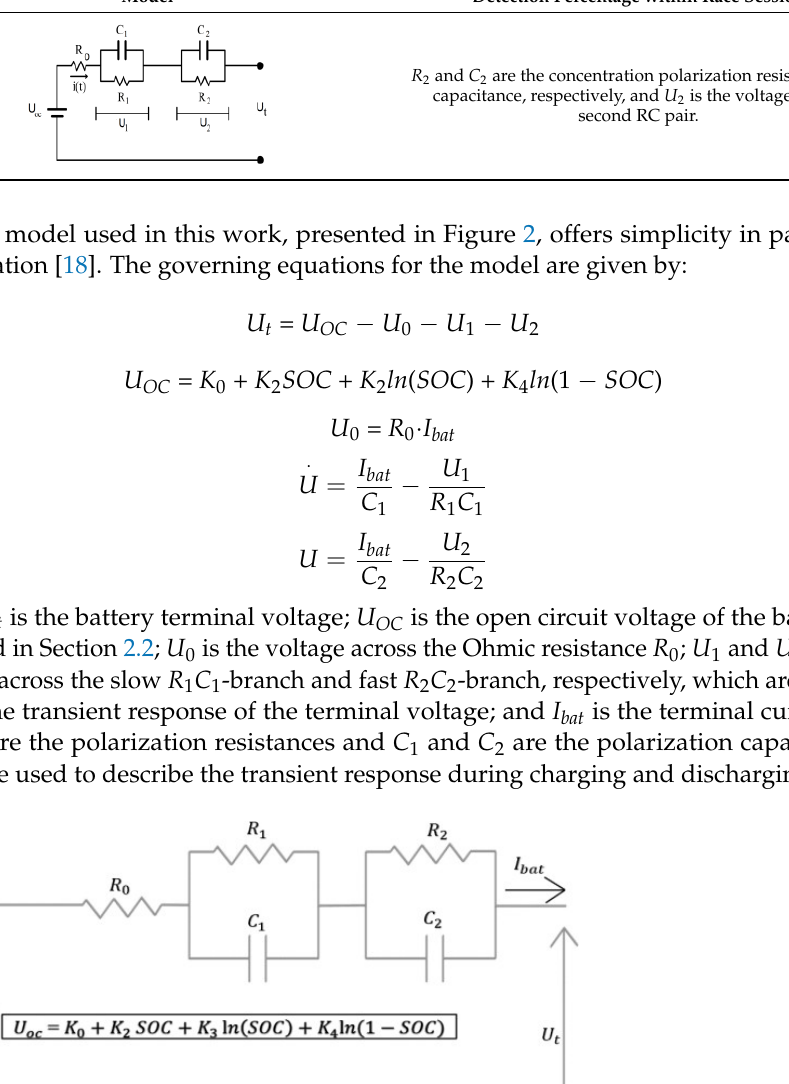
Figure 2. Dual polarization equivalent circuit model with two RC branches.